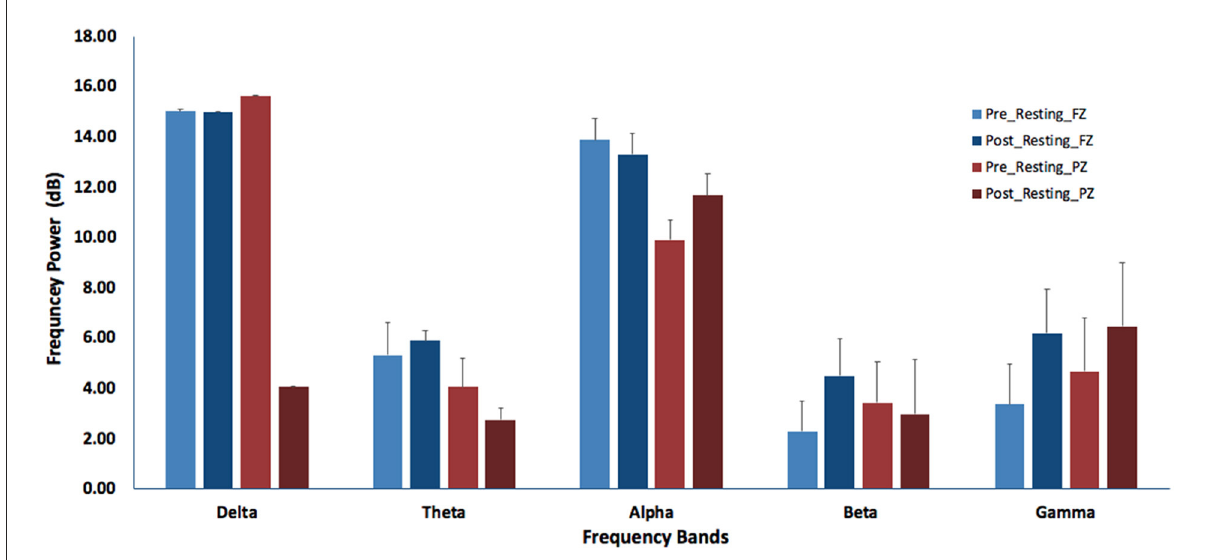
FIGURE3 The band-powers of different EEG spectra before and after Loving-Kindness Meditation at Fz and Pz electrode placements.